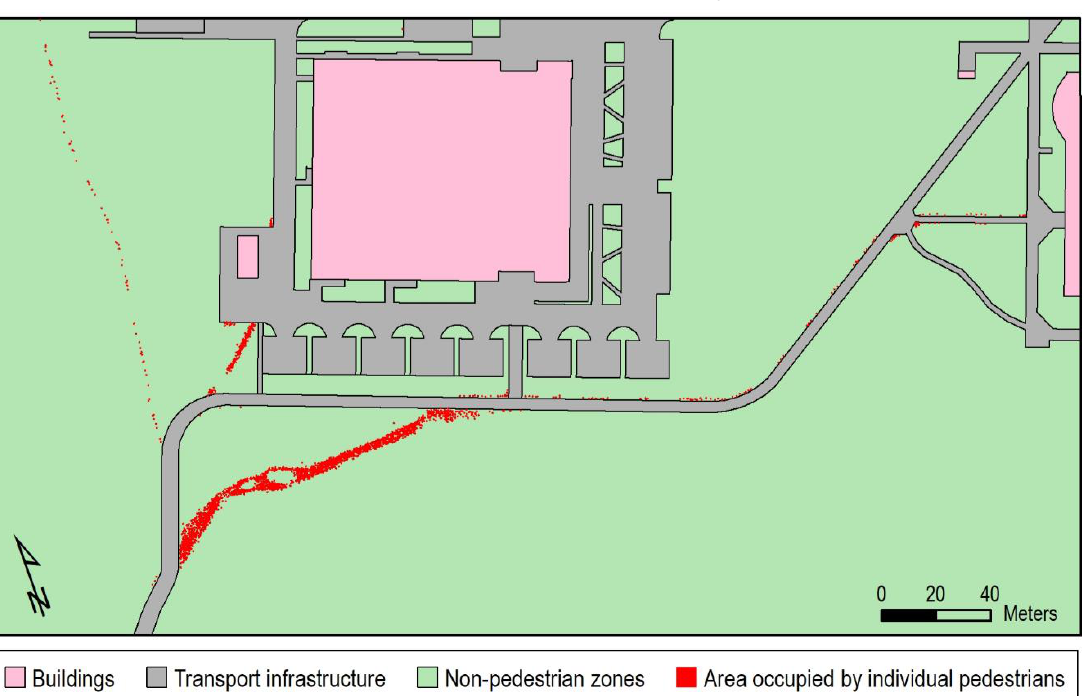
Figure 7. The map of land use with the areas occupied by pedestrians: the chorochromatic method (qualitative data).